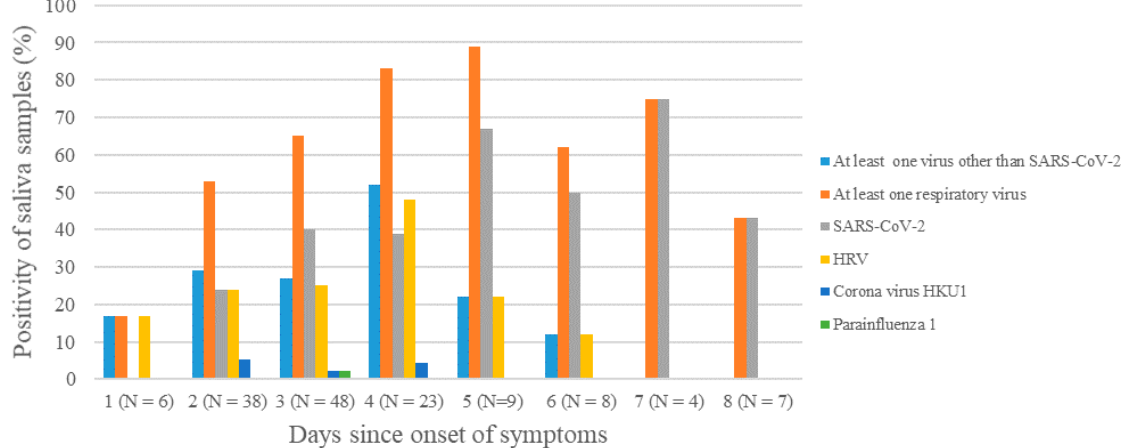
Figure 3. Positivity rates of saliva samples of ARI patients for SARS-CoV-2 and the respiratory viruses other than SARS-CoV-2 analyzed in the present study.